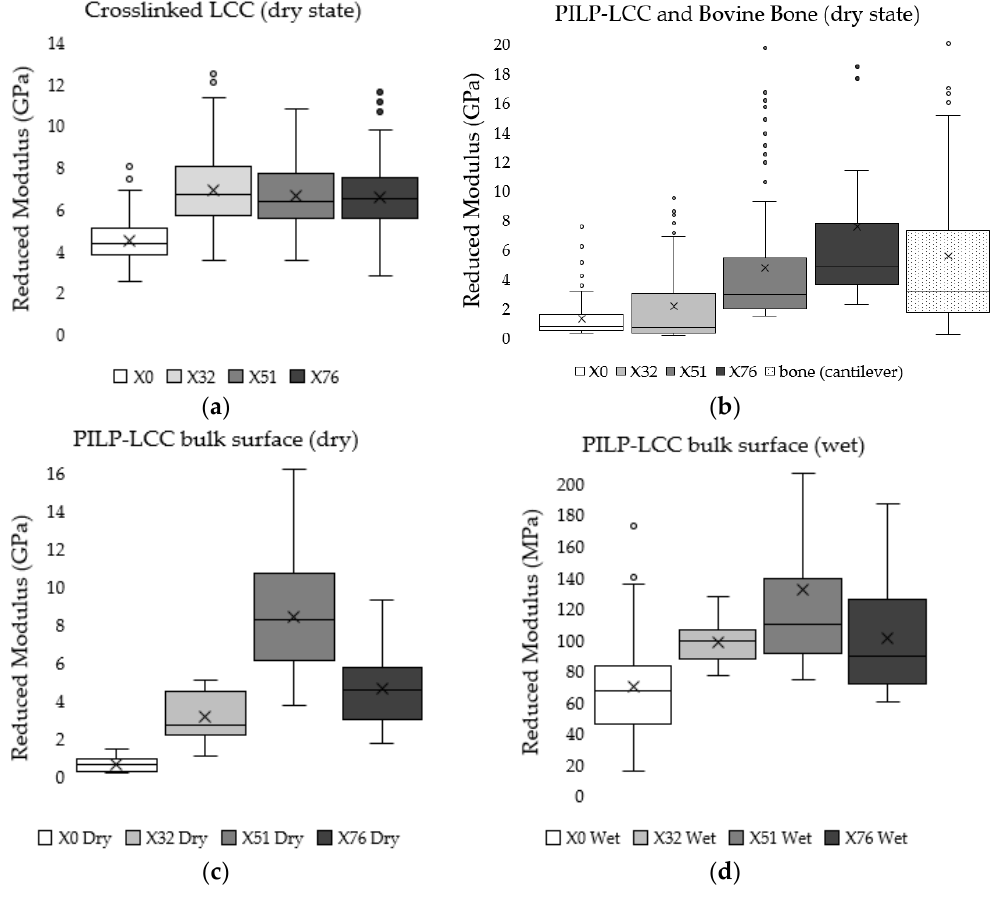
Figure 6. Tukey box-and-whisker plots of indentation moduli help to view the distribution of data from two separate c-bAFM nanoindentation experiments. The box ends represent the upper and lower quartiles, the median is marked by the horizontal line inside the box, the mean is marked by the X, and potential outliers are shown as circles located outside of the whiskers. For a more detailed description of the box-and–whisker plot construction, please see the methods. ( a ) Non-mineralized crosslinked LCC semi-thin cross section tested in the dry state; ( b ) PILP mineralized crosslinked LCC semi-thin cross section compared with native bovine bone; ( c ) Bulk PILP-LCC sample surface measured in the dry state; and, ( d ) Bulk PILP-LCC sample surface measured in liquid after re-hydrating in 1X PBS.